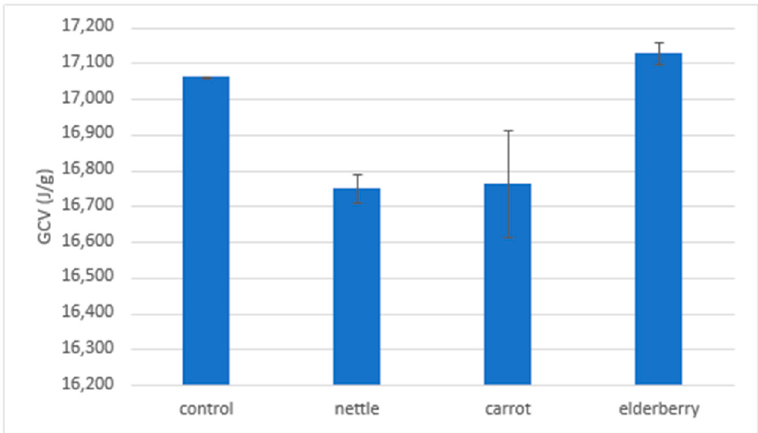
Figure 2. Mean of gross calorific value of all samples with standard error.